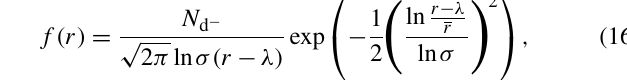
Figure 14. MSP radius to effective radius relation: the blue line shows the MSP radius r d as a function of the effective radius r eff . A linear fit is shown by the green